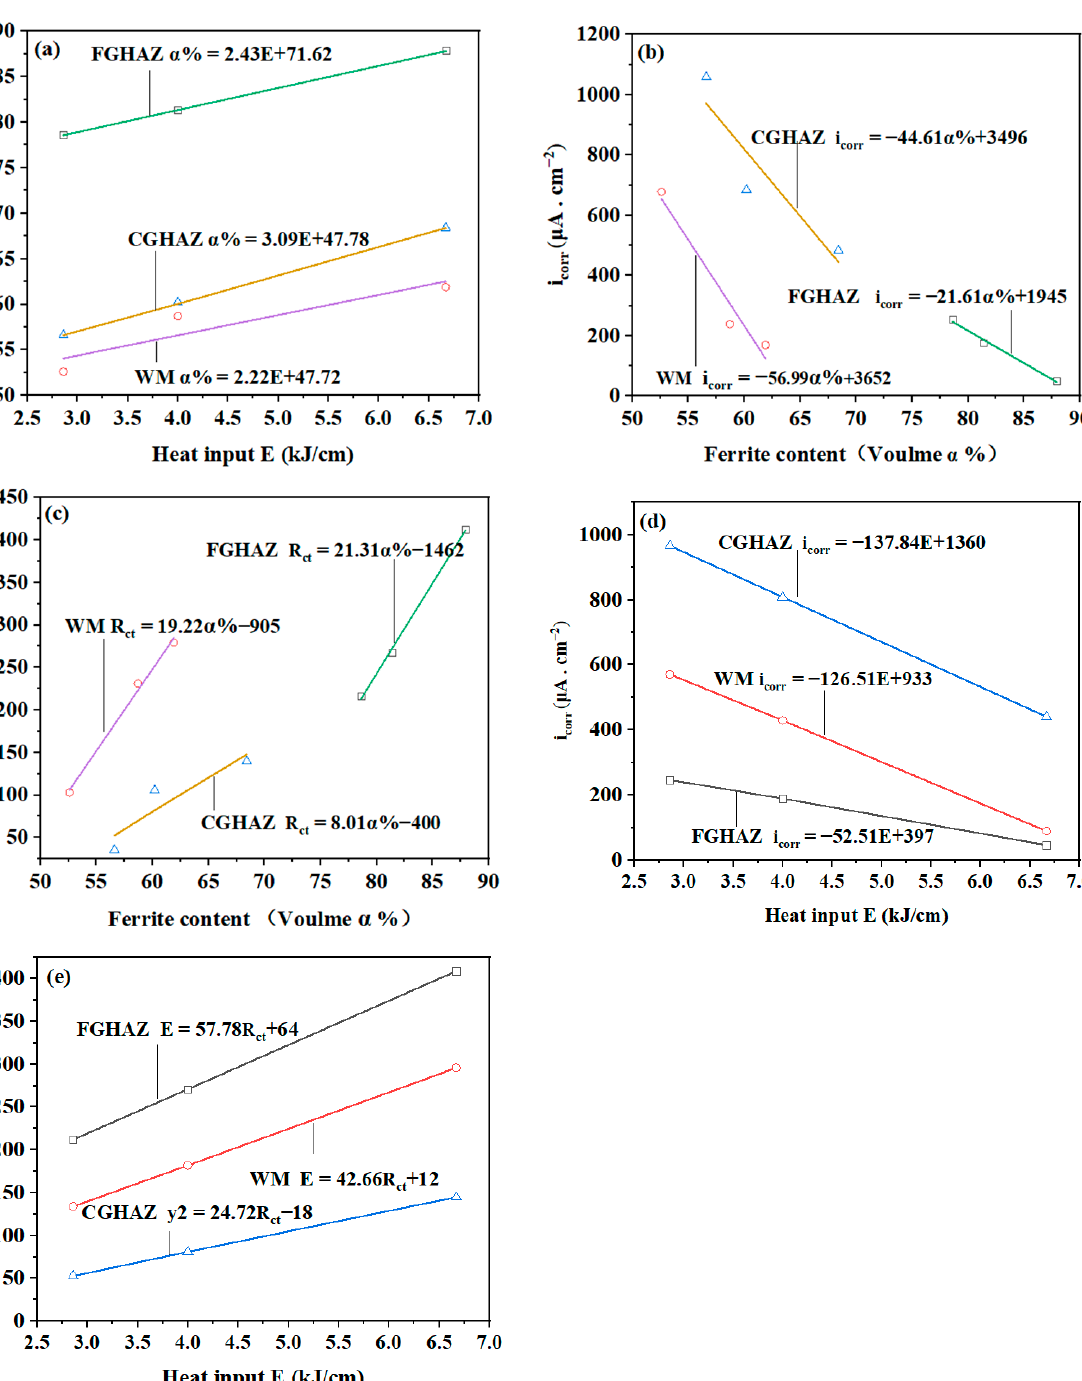
Figure 16. Data-fitting curve: ( a ) fitting diagram of heat input and ferrite proportion function, ( b ) functional model of ferrite proportion and i corr , ( c ) functional model of ferrite proportion and R ct, ( d ) function model of heat input and i corr , ( e ) function model of heat input and R ct .